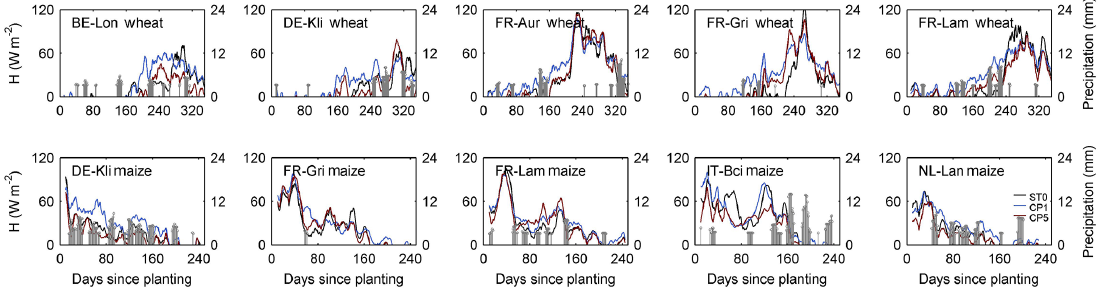
Figure 8. Comparisons between the observed (black line) and modeled daily sensible heat fluxes (H) from ORCHIDEE-CROP (ORC-CP1, blue line; ORC-CP5, brown line) for different crop-sites. The grey stems represent the relative large rainfall events (with daily summed rainfall ≥ 3mm) during the modeled growing season. The upper and lower panel shows the results for different sites of winter wheat and maize,